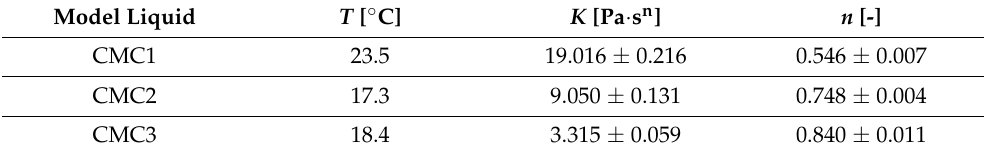
Table 2. The parameters of the power model in Equation (3) were evaluated using the least squares method. Table 2. Parameters of the rheological model describing the flow properties of the used CMC solution.